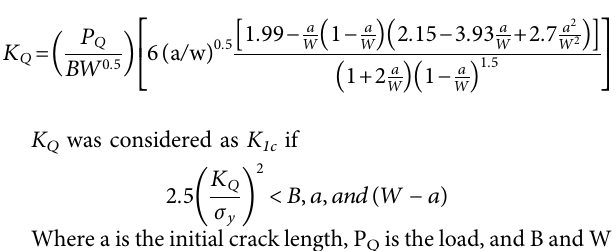
FIGURE 1 | Rheological behavior of the nanocomposite inks. (A,B) Representative log-log plots of shear stress and viscosity vs shear rate. (C) Viscosities and (D) yield shear strengths ofthe nanocomposite inks. The viscosity and yield shear strength values were calculated from the slopes and the y -axis intercepts, respectively, of theshearstressvsshearrateplots.Thedottedbluelineinpanel (C) representstheviscosityvalueofSP10(Mondaletal.,2021).Dataarepresentedasmean±SD( n =3 of each composition). One-way ANOVA and Tukey ’ s multiple comparison test were used for statistical analysis. Different small-case letters indicate statistical signi fi cance at p <